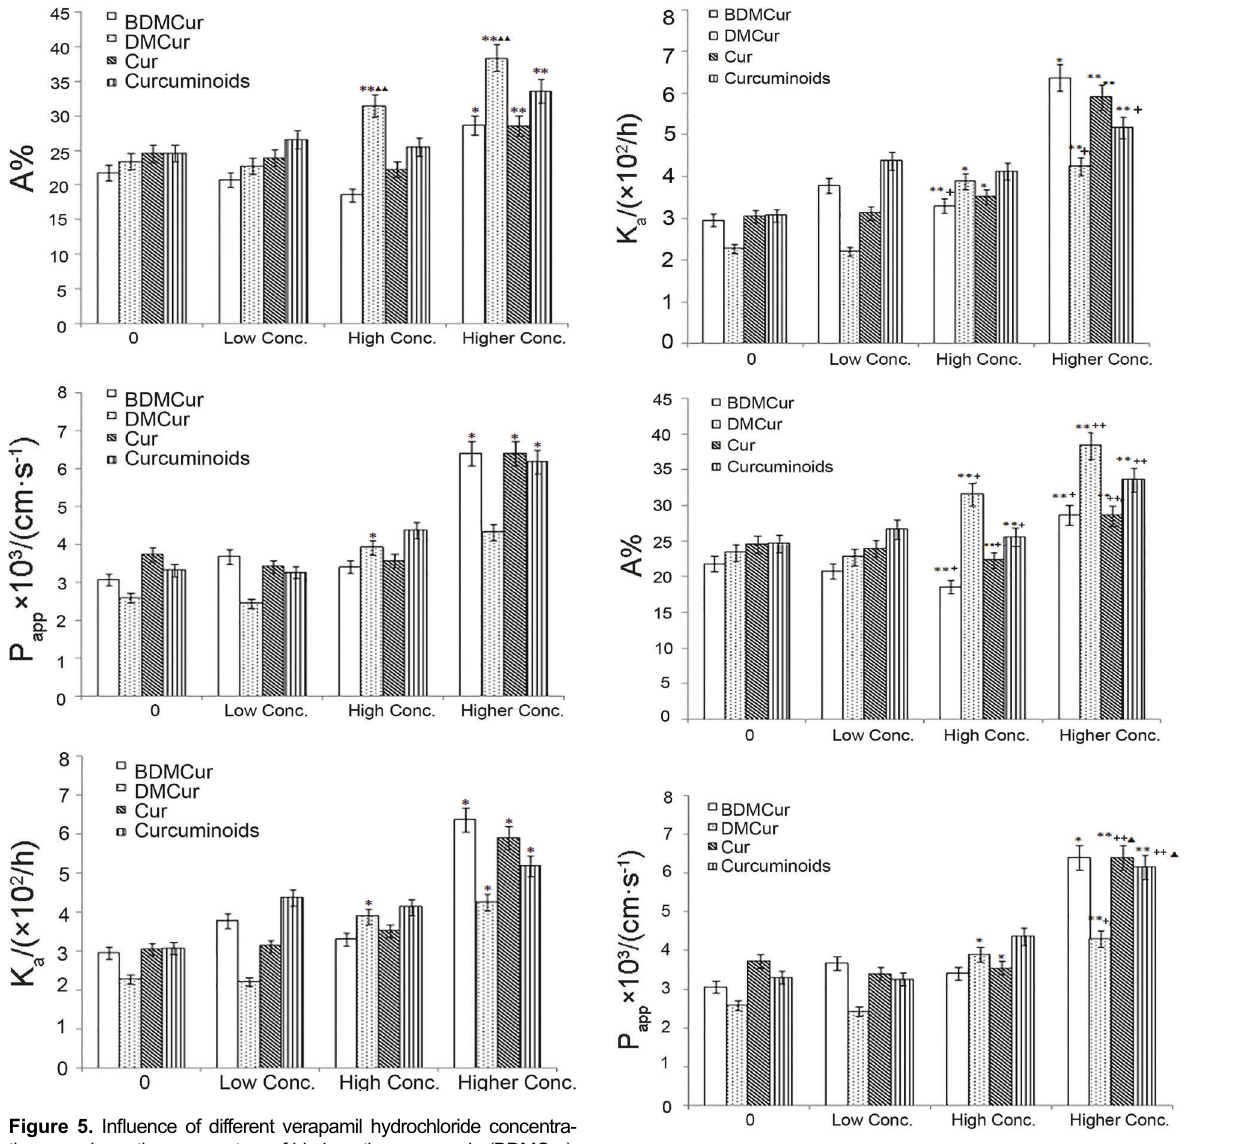
Figure 6. In fl uence of different probenecid concentrations on absorption parameters of bisdemethoxycurcumin (BDMCur), demethoxycurcumin (DMCur) and curcumin (Cur). Top : absorp- tion rate constant (K a ); middle : absorption percentage (A%); and bottom : drug apparent absorption coef fi cient (P app ). Conc: concentration. **P o 0.01, *P o 0.05 compared to medicine group without MRP2 inhibitor; ++ P o 0.01, + P o 0.05 compared to medicine group with low concentration of MRP2 inhibitor; m P o 0.05 compared to medicine group with high concentration of MRP2 inhibitor with the energy inhibitor decreased in an extremely signi fi cant manner (P o 0.01). Furthermore, both K a and P app decreased signi fi cantly (P o 0.05). These indicate that the intestinal absorption process of BDMCur, DMCur